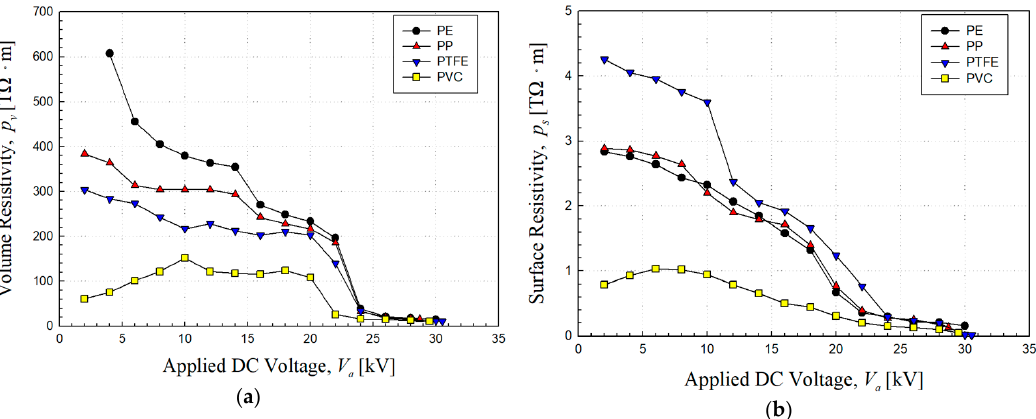
Figure 12. Volume and surface leakage resistivity characteristics for each insulating material according to the applied DC voltage: ( a ) volume resistivity; ( b ) surface resistivity. Table 2. Volume and surface resistivity of insulating materials.